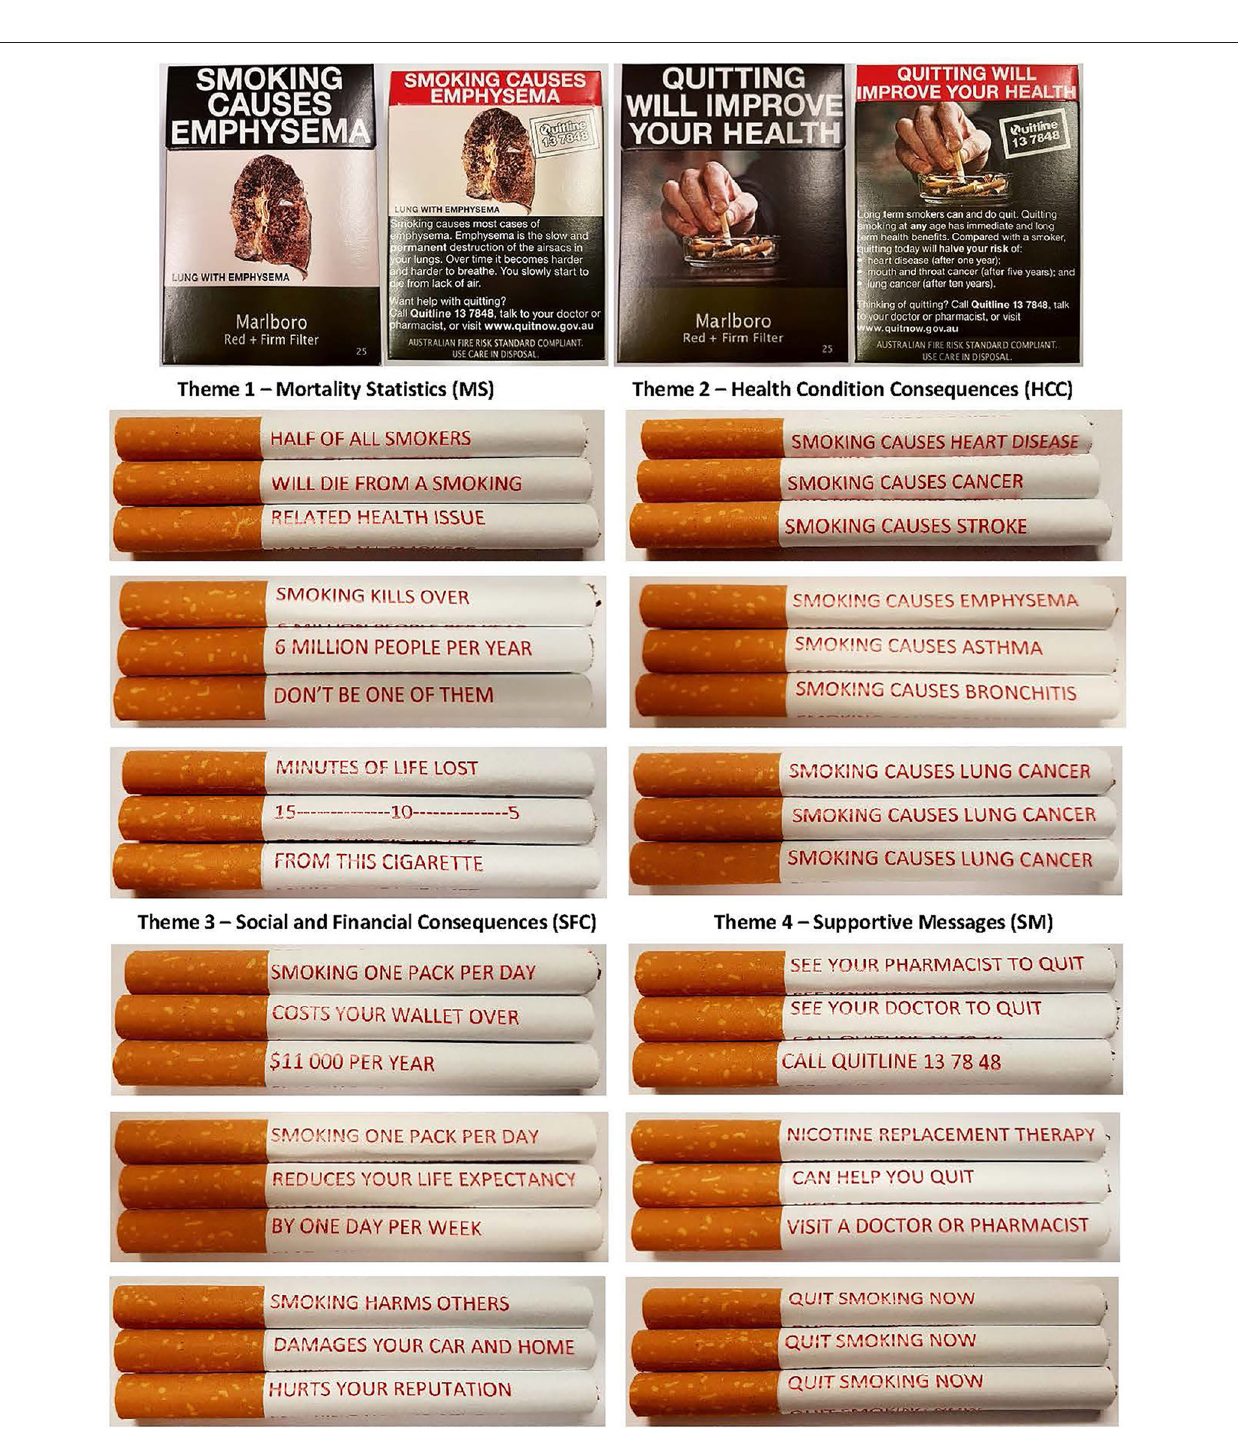
smokers to quit. Each question had optional open-text boxes participants could use to include details relating to their chosen response on the Likert scale. Participants were then given the